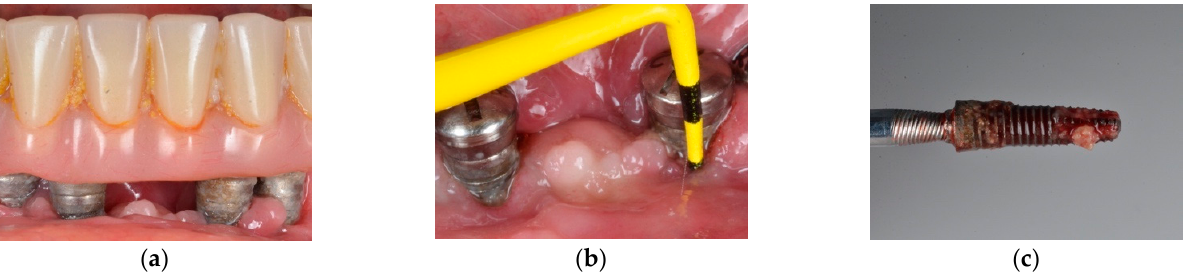
Figure 3. ( a ) Clinical appearance at several implant-supported fixed prosthesis involved affected of advanced peri- implantitis; ( b ) clinical probing indicates advanced attachment loss; ( c ) implant removal is suggested in advanced forms of